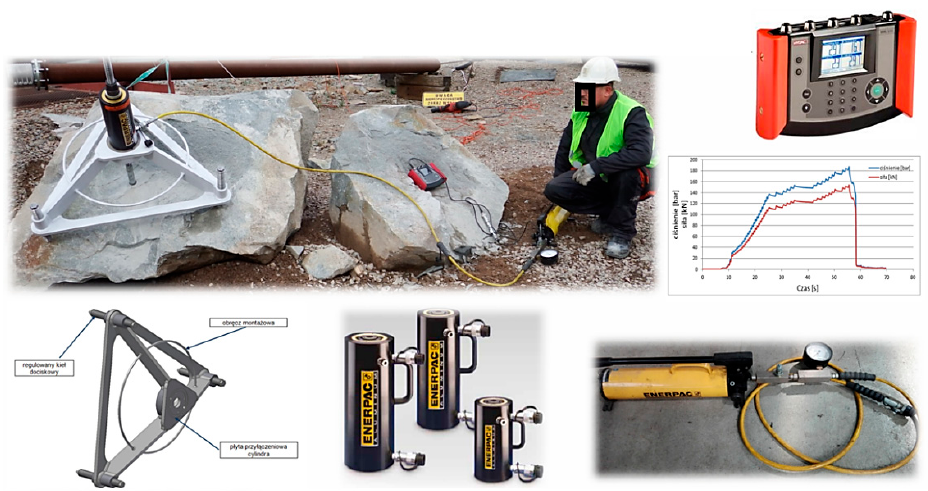
Figure 9. Components of the mobile tensile test setup.